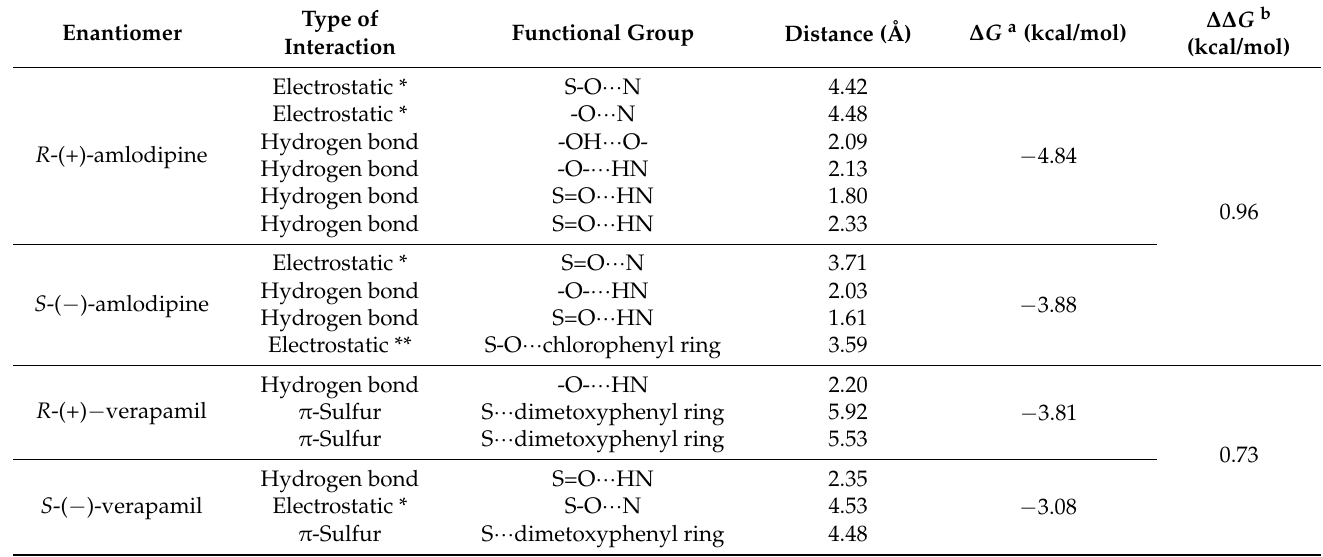
Table 3. Proposed interactions by molecular docking and binding energies.